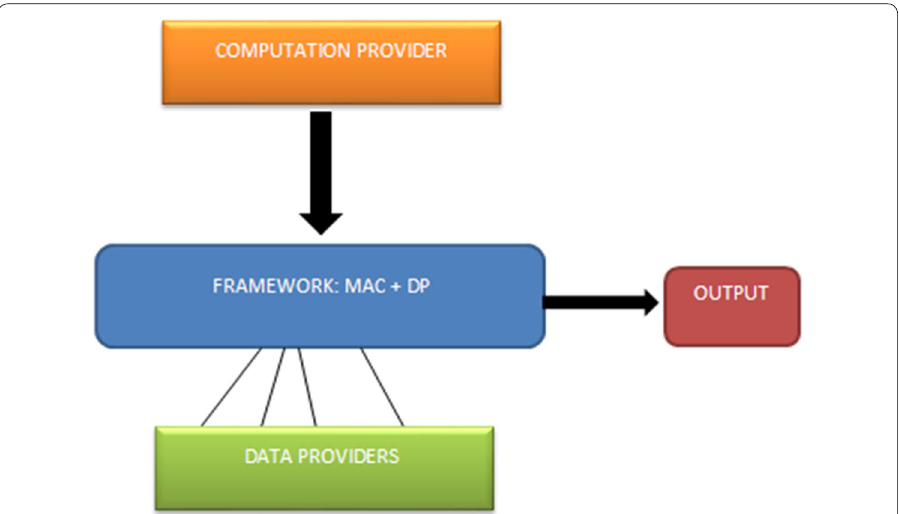
Fig. 7 Framework for access control and DP